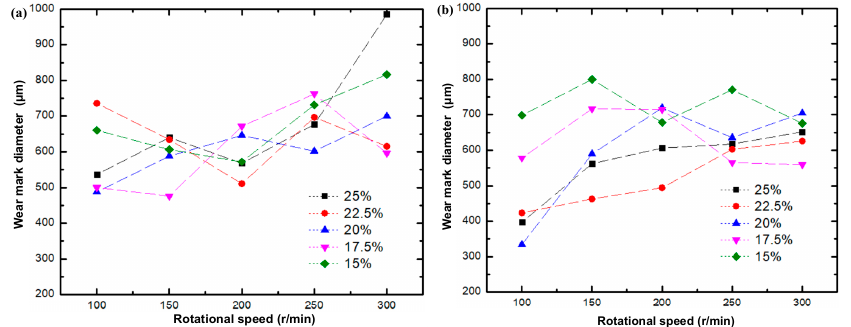
Figure 11. Change curve of wear scar diameter of composites of different initial phase solids content with rotational speed: ( a ) Water-based drilling fluid; ( b ) Dry friction. Figure 12 illustrates the surface morphology of the 25 wt. % initial solid phase content composite, representative of testing conducted in both lubricated and dry conditions at a fixed speed of 200 r/min, with respective loads of 1 N, 2 N, 3 N, 4 N, and 5 N. Figure 13 shows the change curve of the diameter of the wear scar on the layered Al 2 O 3 /PMMA composites comprised of different solid phase